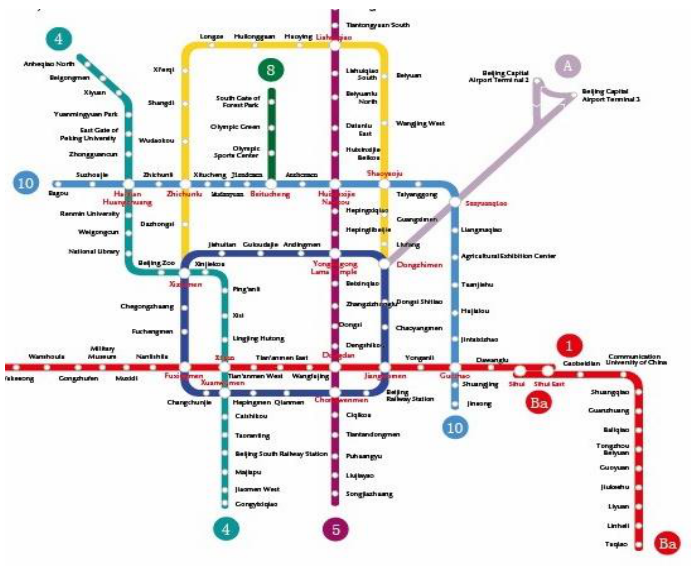
Fig 2. Sketch map of Beijing urban rail transit network